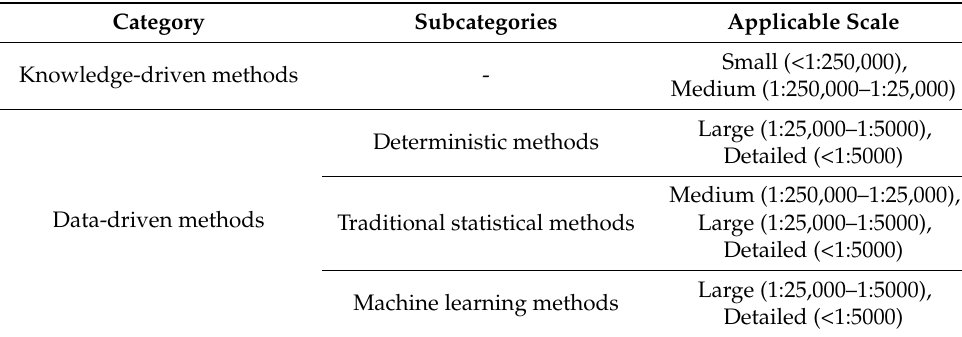
Table 1. Existing methods of landslide susceptibility